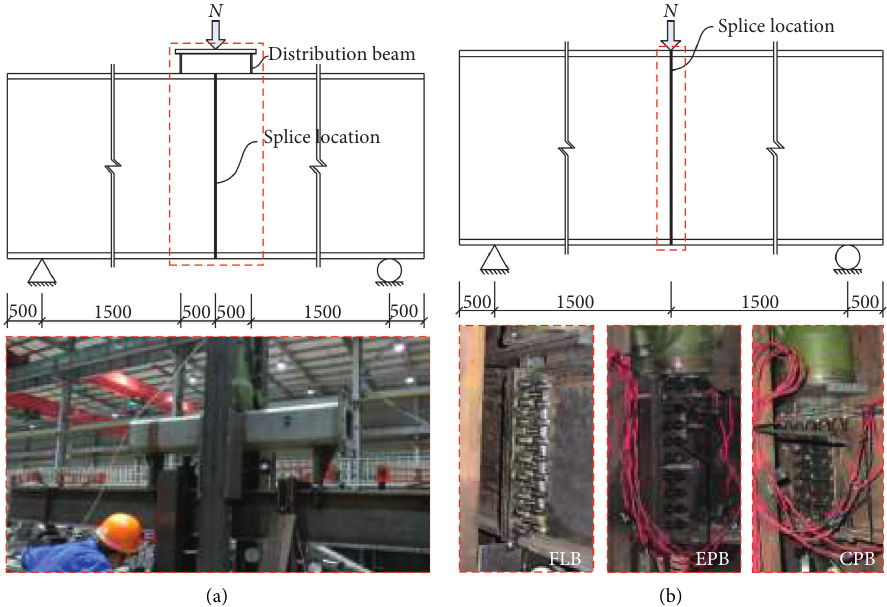
Figure 4: Test setup. (a) Pure bending loading scheme. (b) Midspan loading scheme.